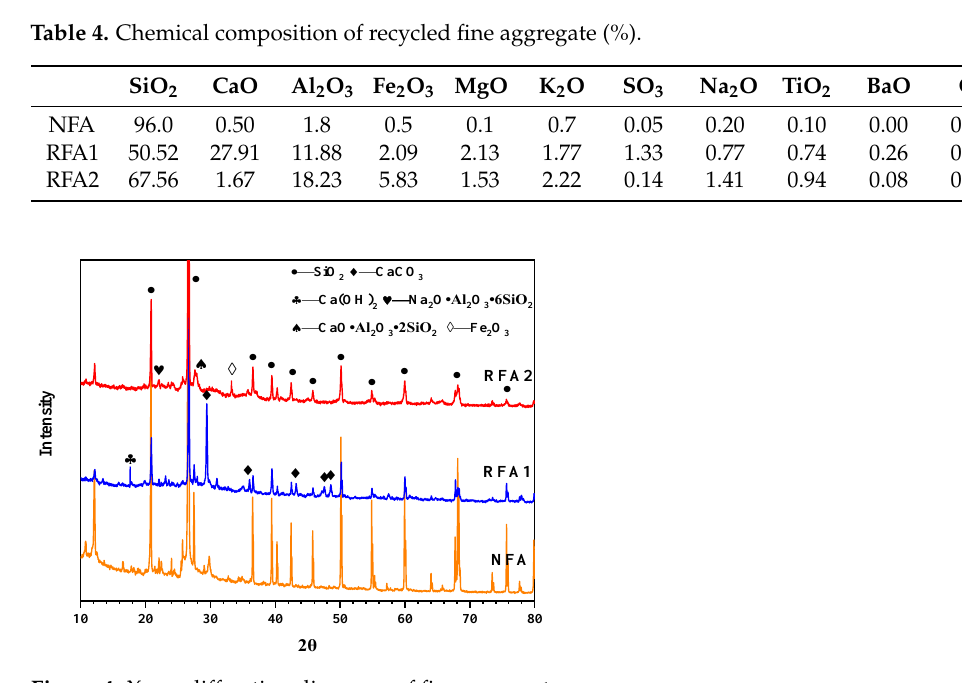
Figure 4. X-ray diffraction diagrams of fine aggregate.